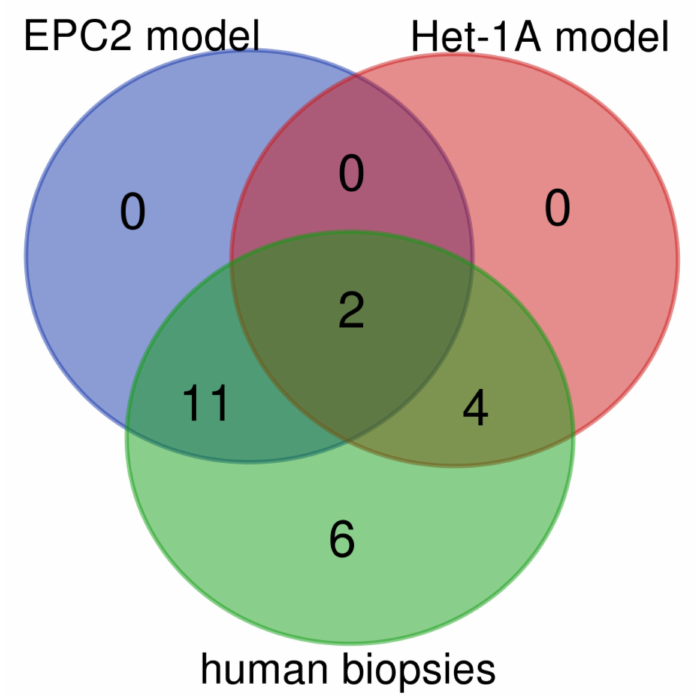
Figure 11. Venn diagram displaying numbers of up / downregulated genes in human biopsies derived from patients with Barrett’s metaplasia as compared with in vitro Het-1A and EPC2 model of Barrett’s esophagus. Overlap area shows the number of the same up / downregulated genes in the appropriate groups. Graphs were obtained through Venn diagrams software (available online: http: // bioinformatics. psb.ugent.be / webtools / Venn / ). Di ff erent colors mean di ff erent